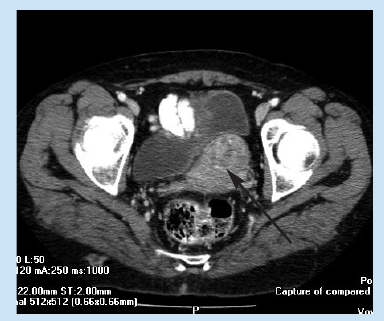
Fig. 11. Unusual early uterine